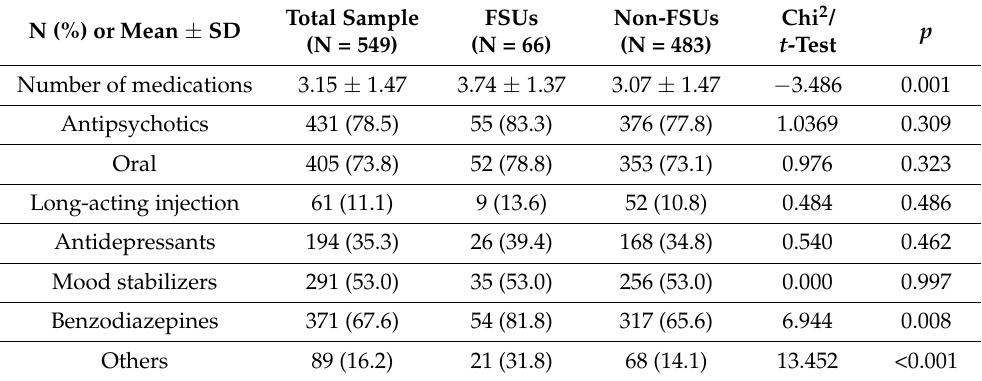
Table 4. Pharmacological treatment of the entire sample and of the frequent service users (FSUs) and non-FSUs